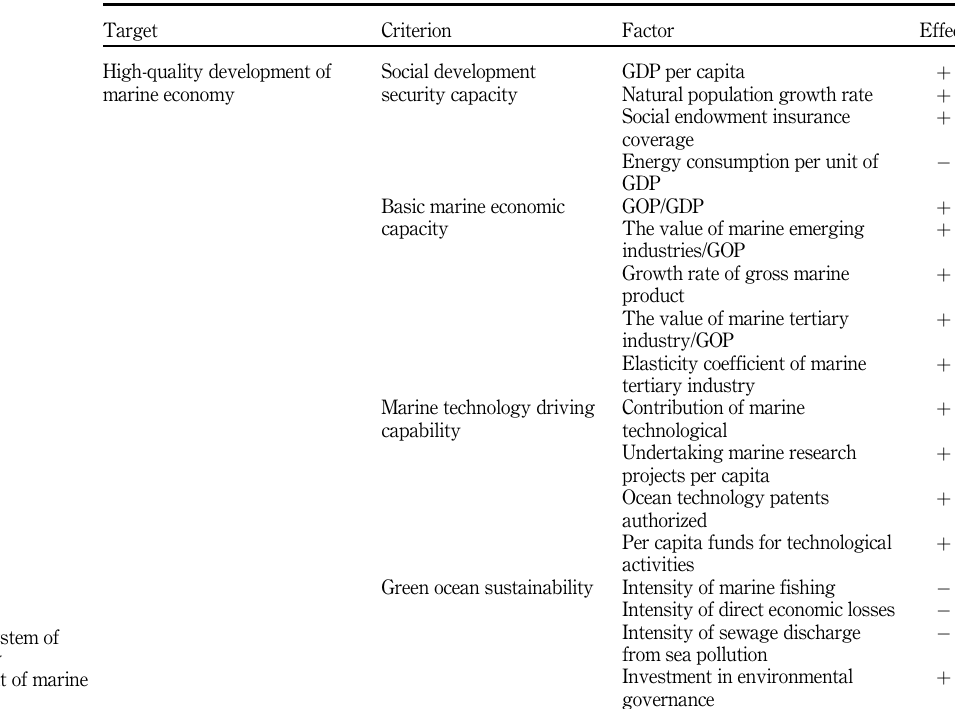
Table 2. Consistency test of expert assignment of a single indicator